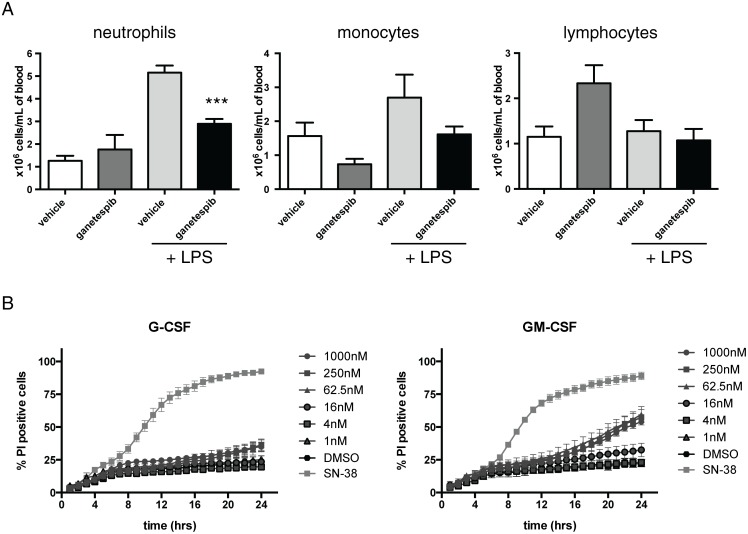
Ganetespib does not suppress basal circulating blood neutrophils but inhibits LPS induced mobilization without causing neutrophil apoptosis.Balb/c mice were treated with ganetespib (100 mg/kg, i.v. or vehicle) and challenged with LPS (10 µg/mouse tn). (A) 24 h post-LPS peripheral blood counts and blood smears were obtained. Smears were manually differentiated into neutrophils, monocytes and lymphocytes. Total leukocytes were quantified and differentiated using standard morphological criteria of fixed and stained blood smears. Data are mean ± SEM. n = 6–8 mice per group (n = 3 for ganetespib alone). Note that ganetespib did not significantly reduce basal neutrophil numbers but suppressed mobilization post-LPS. (B) Kinetic profile of the effect of ganetespib on neutrophil survival as assayed by live cell imaging. Neutrophils were treated with ganetespib, (concentrations as shown) or 10 µM SN-38 (positive control), for 15mins before addition of 10ng/mL G-CSF or GM-CSF. Data points represent means +/- SEM of three independent samples. p<0.001 for SN-38 vs DMSO from 8h in G-CSF and GM-CSF-treated cells. p<0.05 for 250nM GIB vs DMSO at 24h in G-CSF-treated cells. p< 0.05 for 62.5, 250nM, 1000nM GIB vs DMSO from 19h in GM-CSF-treated cells.